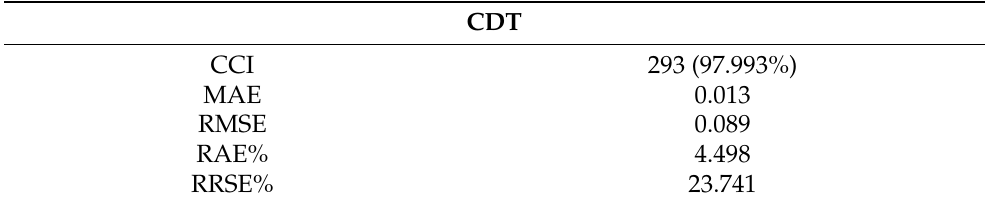
Table 17. CCI and Error Rates details achieved via